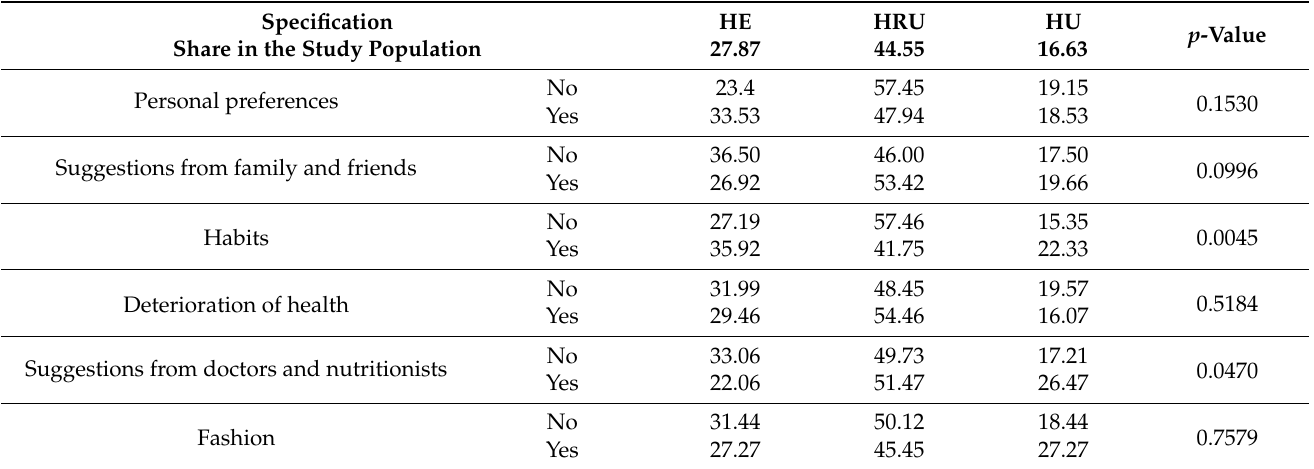
Table 5. Clusters characteristics by reasons for using bee products (n = 487, data in %).